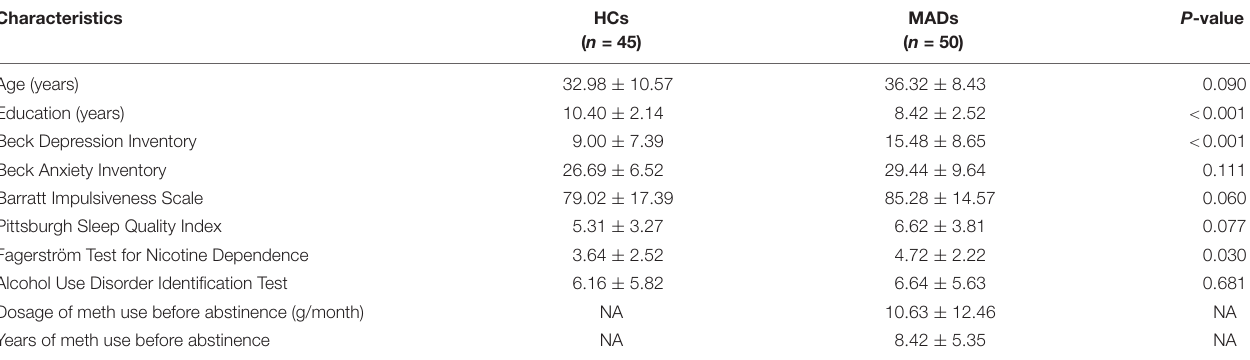
TABLE 1 | Demographic variables of the participants in Experiment 1 (mean ± SD).